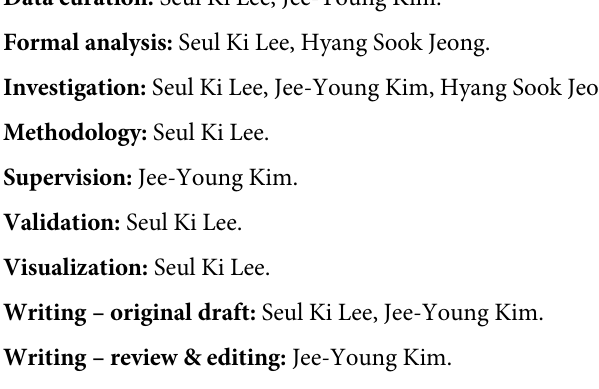
S1 Table. Logistic regression analysis between two groups against MRI findings. S2 Table. Comparison of MRI findings between digital schwannoma and major-nerve